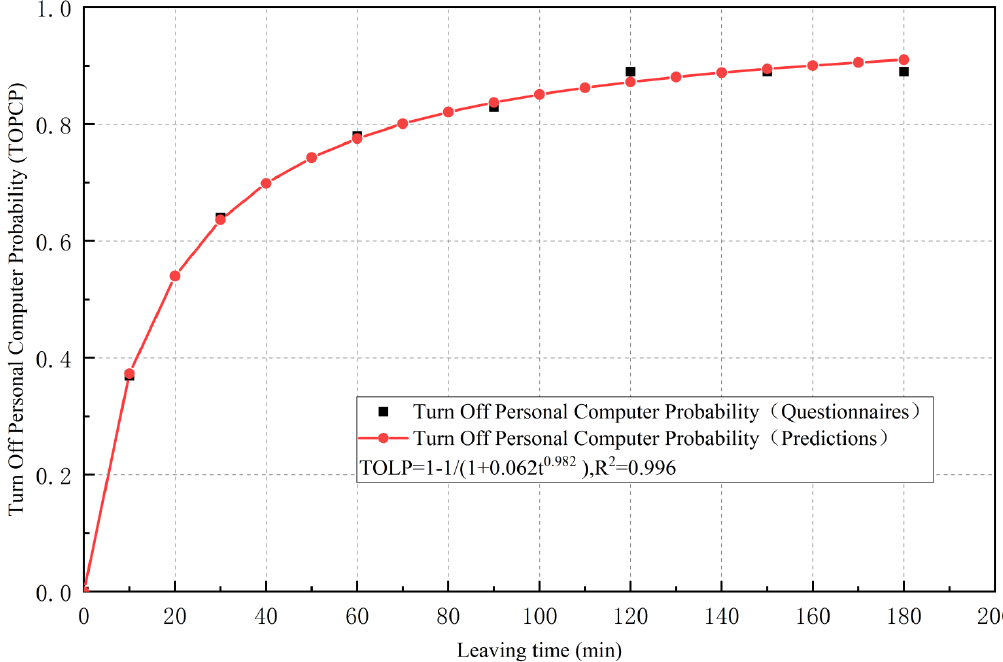
Figure 15. Shutdown probability according to the departure duration.